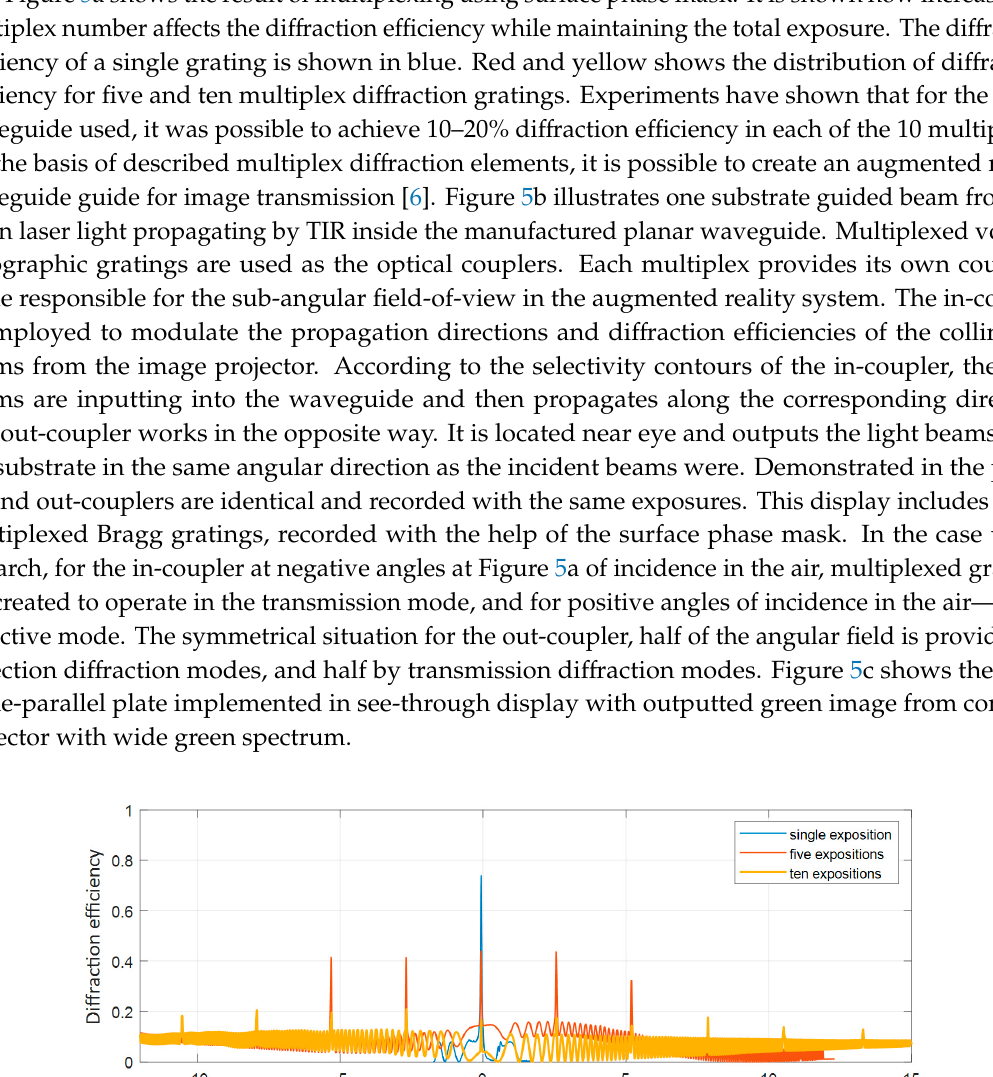
Figure 4. Measurements of the diffraction efficiency via exposition dose of multiplexed grating: ( a ) Recorded by Bragg phase mask with five exposures; and ( b ) relief phase mask with seven exposures.